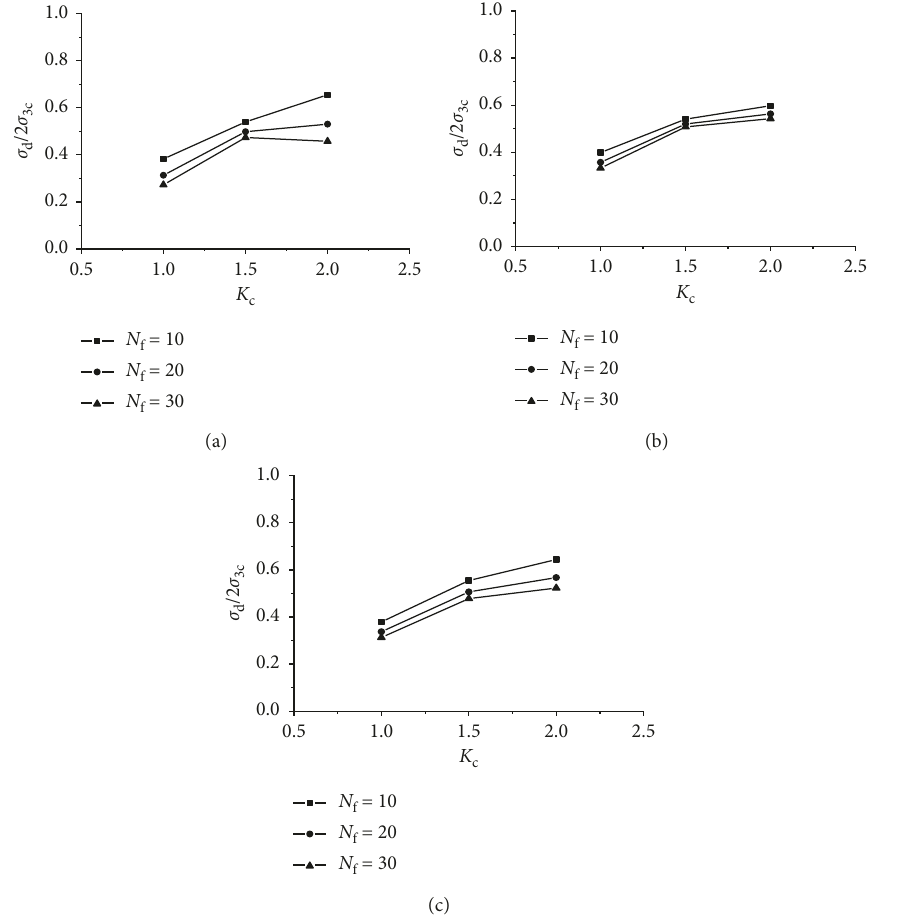
Figure 3: Relationship curves between cyclic stress ratio and consolidation ratio: (a) σ